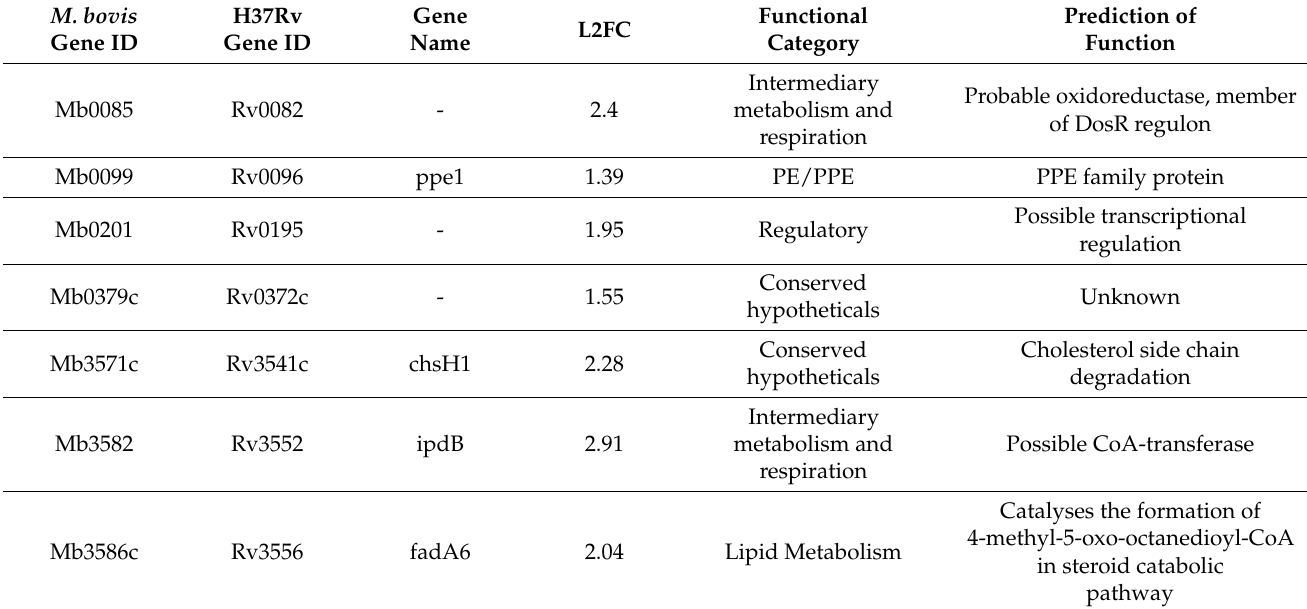
Table 1. Genes induced by M. bovis BCG after macrophage infection that are also essential for growth in macrophages [14], but not essential for growth and cholesterol catabolism in vitro